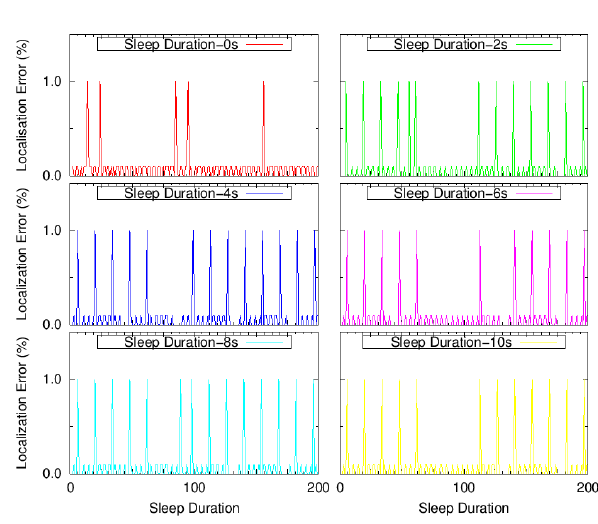
Figure 19. Localization error variation with change in